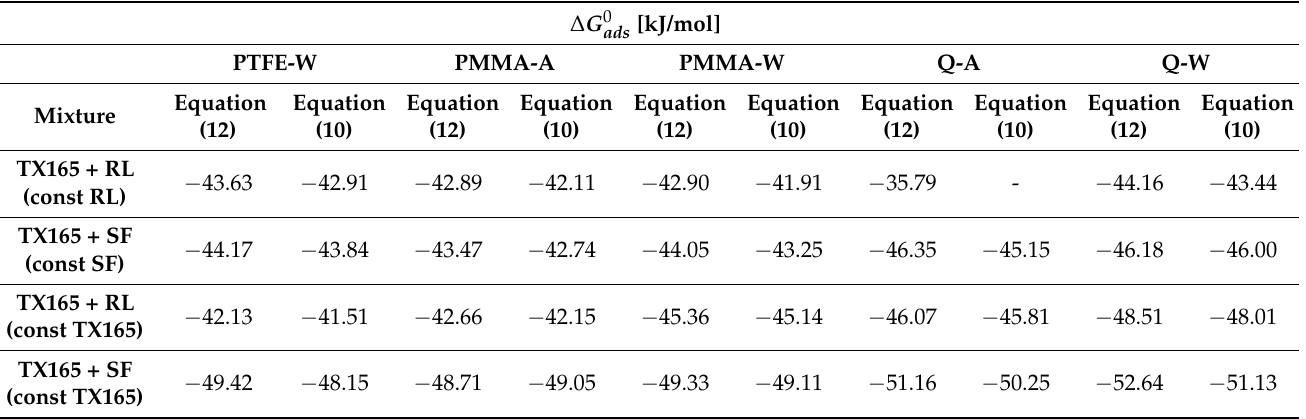
Table 4. The values of standard Gibbs free energy of adsorption of TX165, RL and SF ( ∆ G 0 the PTFE-water, PMMA-water, quartz-water, PMMA-air and quartz-air interfaces calculated from Equations (10) and (12)